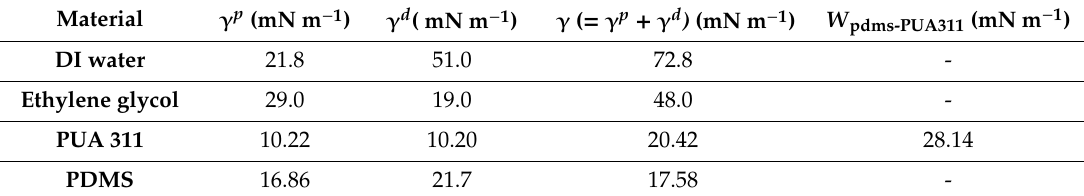
Figure 5. Measurements of the contact angle of DI water and ethylene glycol on the surface of PUA 311 and PDMS. Table 1. Surface energy of the